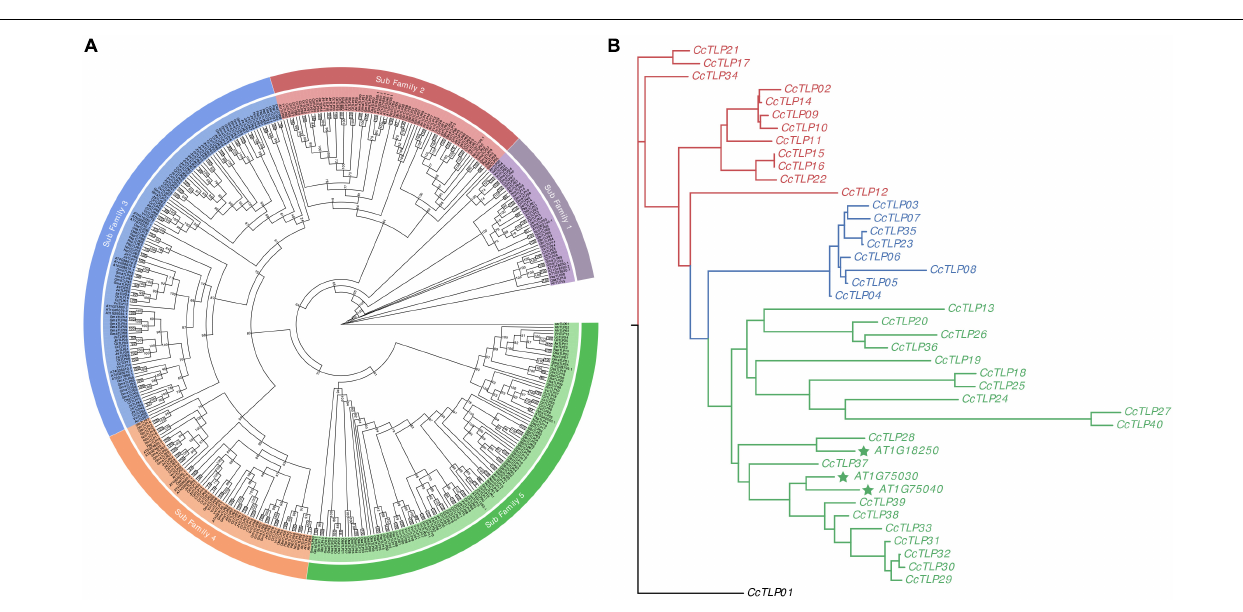
number of TLP genes (115, including 18 hickory TLP